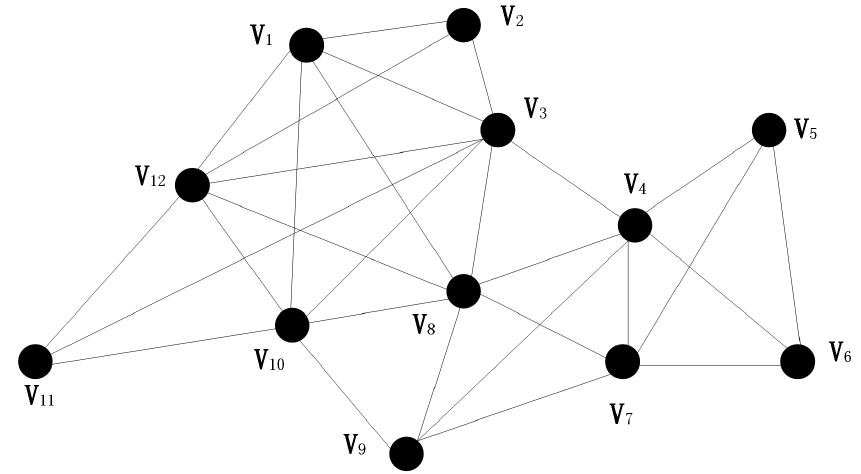
Figure 1. A 12-node network as an example, to show the division of nodes based on